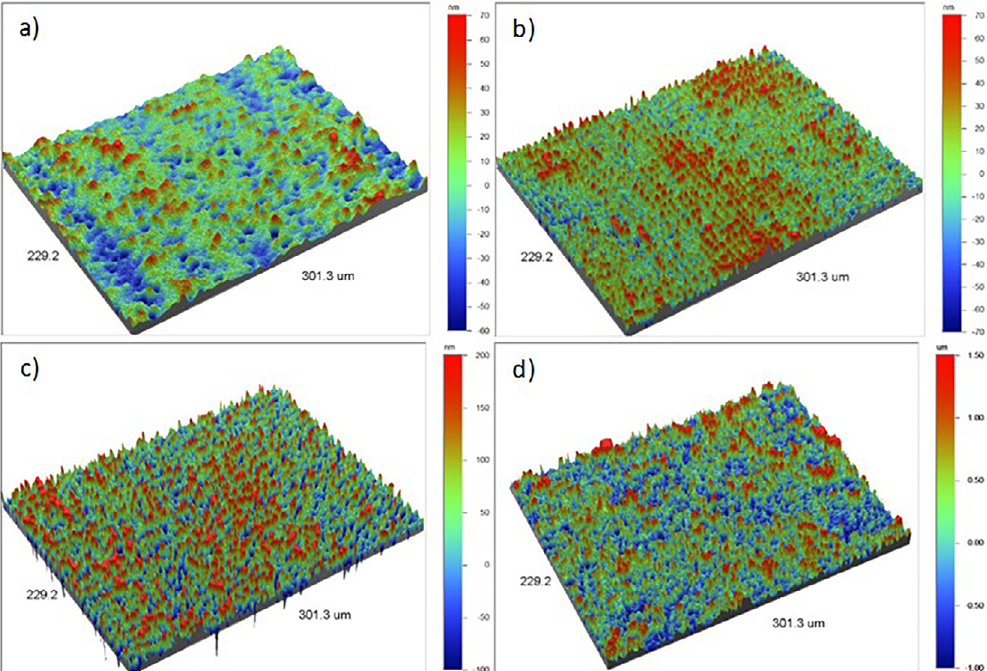
Figure 4. Profilometry topographies (area: 229.2 × 301.3 µm) of polished Ti6Al4V samples. (a) untreated control: scale −60 to 70 nm; (b) etched at 25 °C: scale −70 to 70 nm; (c) etched at 40 °C: scale −100 to 200 nm; and (d) etched at 60 °C: scale −1000 to 1500